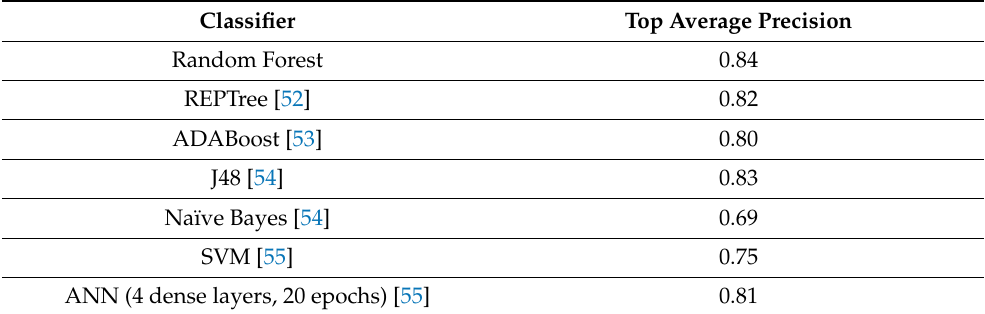
Table 4. Comparison between top average precisions reported by various selected classifiers.